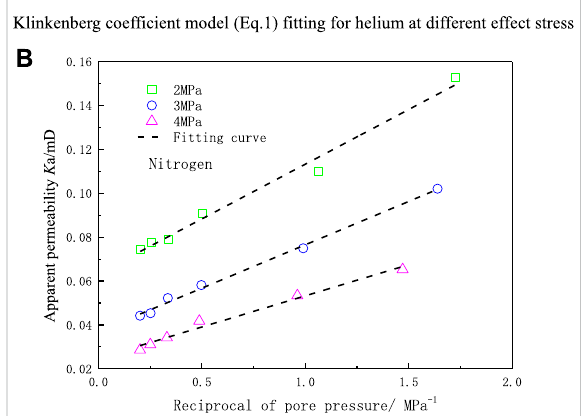
FIGURE 3 Klinkenberg coef fi cient model fi tting results of experimental data. (A) Klinkenberg coef fi cient model (Eq. 1) fi tting for helium at different effect stress (B) Klinkenberg coef fi cient model (Eq. 1) fi tting for nitrogen at different effect